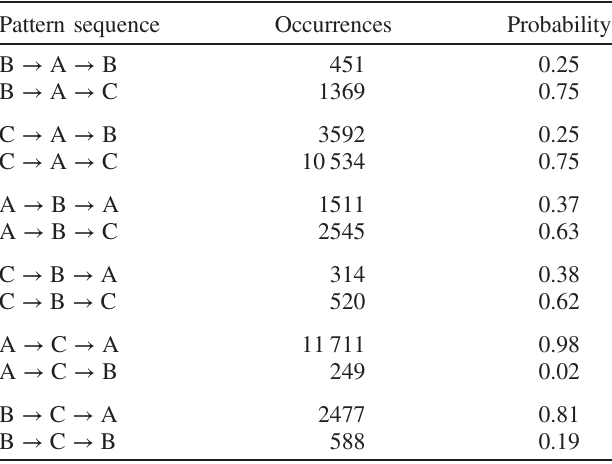
TABLE I. Number of occurrences of length-3 subsequences of the pattern sequence in 100 × ð 2 × 10 6 Þ time units and their respective probabilities given a fixed middle pattern. Only for subsequences with pattern C (event) in the middle does the last pattern significantly depend on the first one (Fisher ’ s exact test [77], Bonferroni-corrected, significance level 0.05). For longer subsequences (up to length 18), no comparable dependencies were